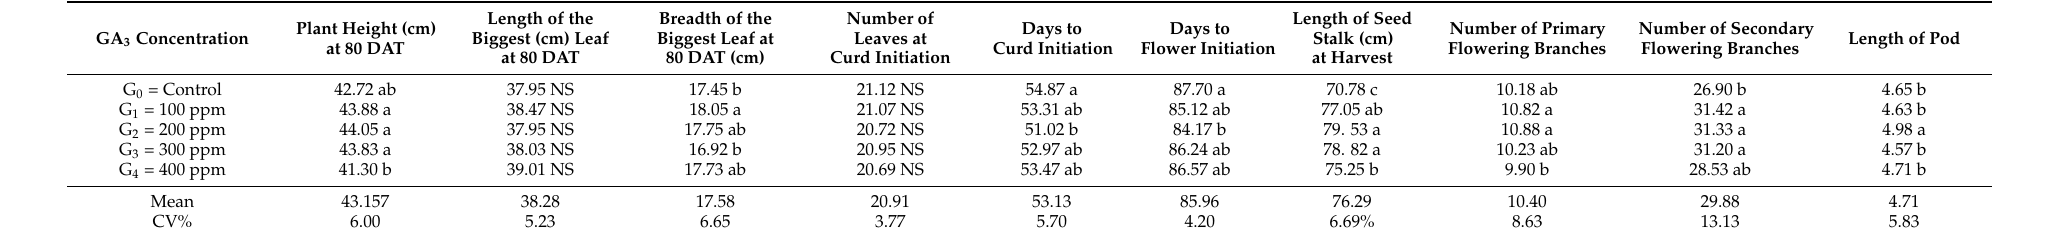
Table 1. The main effect of GA 3 concentration on morphological traits in BU cauliflower-1.